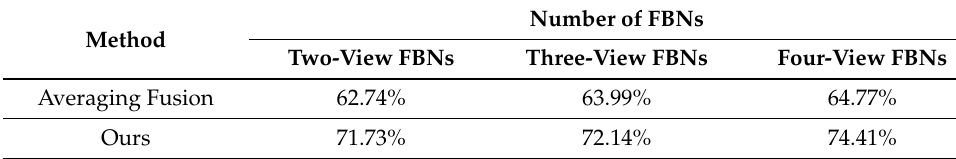
Table 5. Influence of the number of FBNs based on a t-test with a p -value of 0.001.